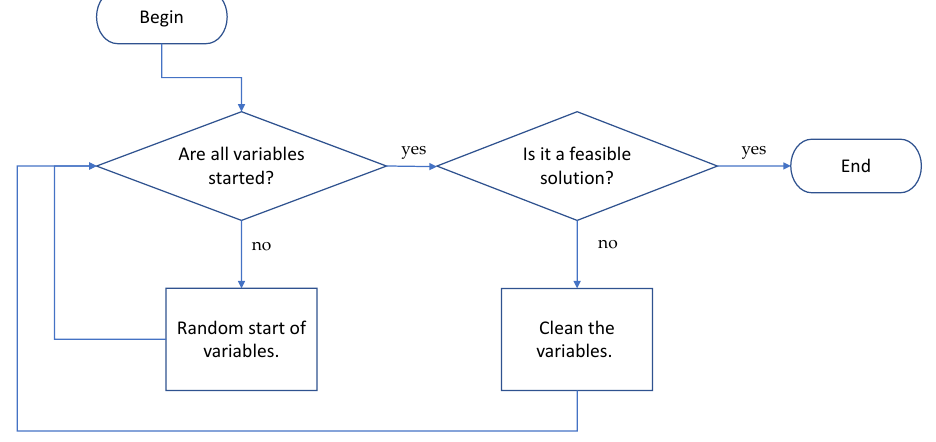
Figure 5. Solution initiation procedure [10].